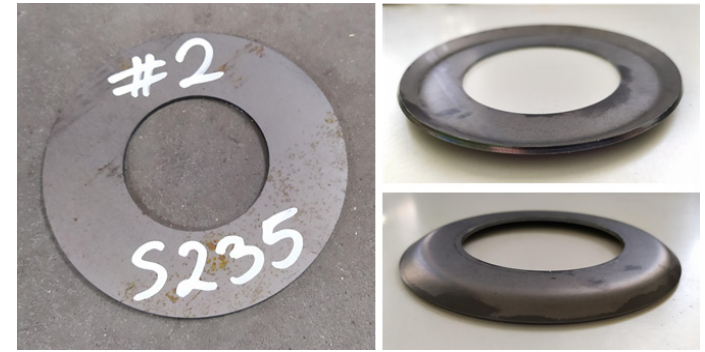
Figure 2. Detail before ( left ) and after extrusion ( right